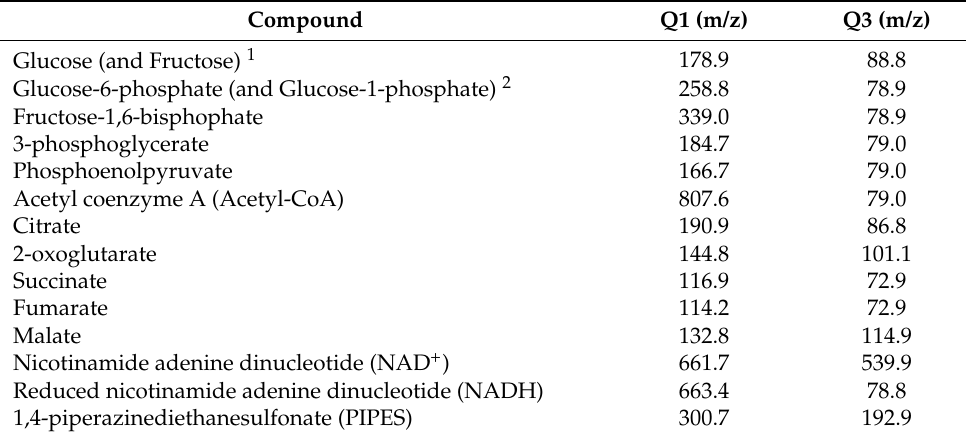
Table 2. Optimized Q1 and Q3 values for the analyzed